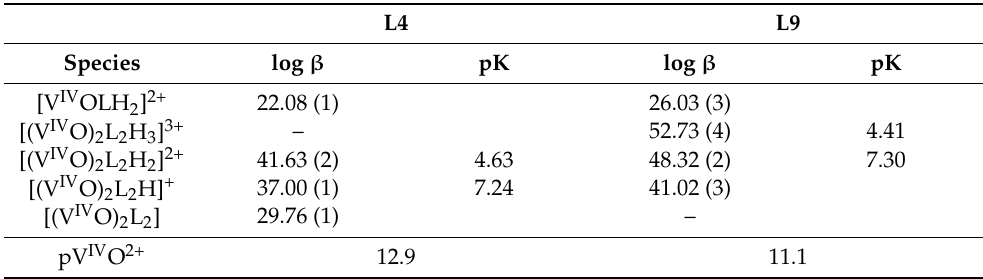
Table 2. Complex formation constants of V IV O 2+ with L4 and L9 evaluated from combined potentiometric-UV titrations at 25 ◦ C, 0.1 M NaCl ionic